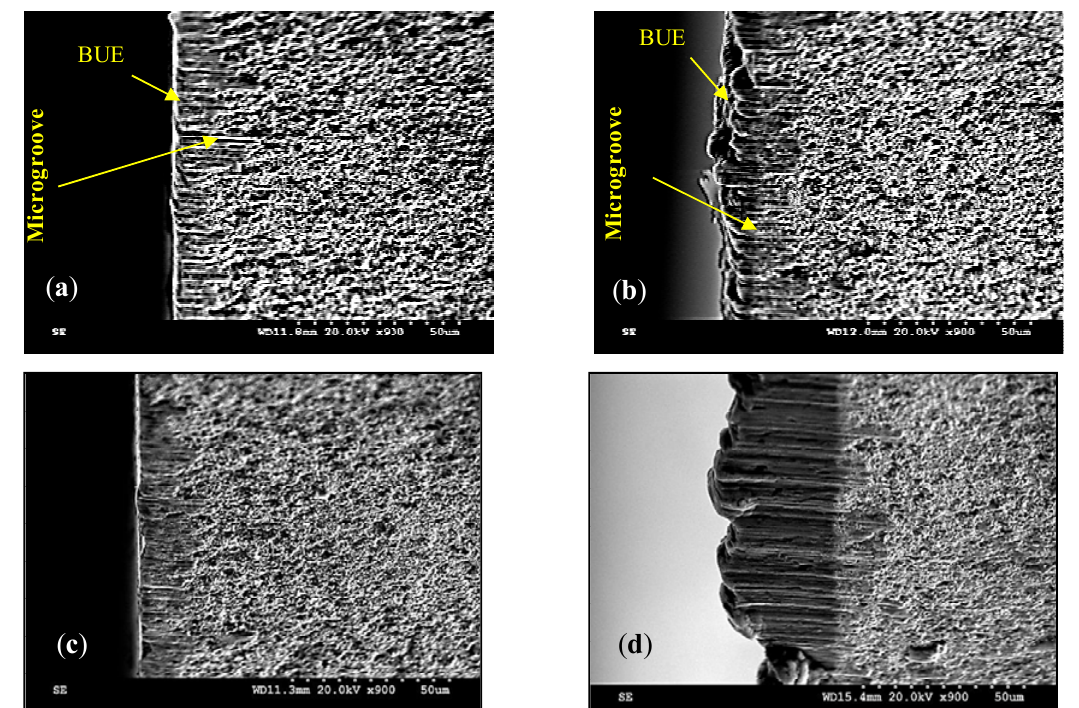
Figure 7. Flank face of the cutting tool after machining at ( a ) Trail #1; ( b ) Trial #2; ( c ) Trial #3; and ( d ) Trial